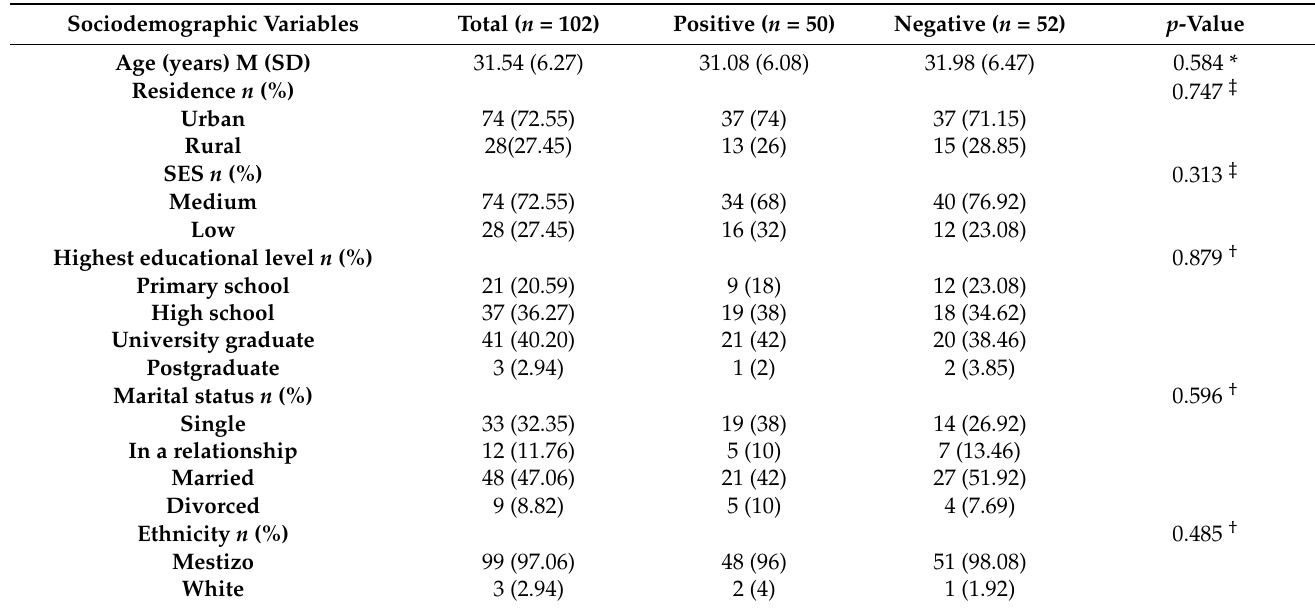
Table 1. The association of sociodemographic variables with positive or negative results obtained for sexually transmitted diseases (STDs) caused by Chlamydia trachomatis , Neisseria gonorrhoeae , and Ureaplasma urealyticum.